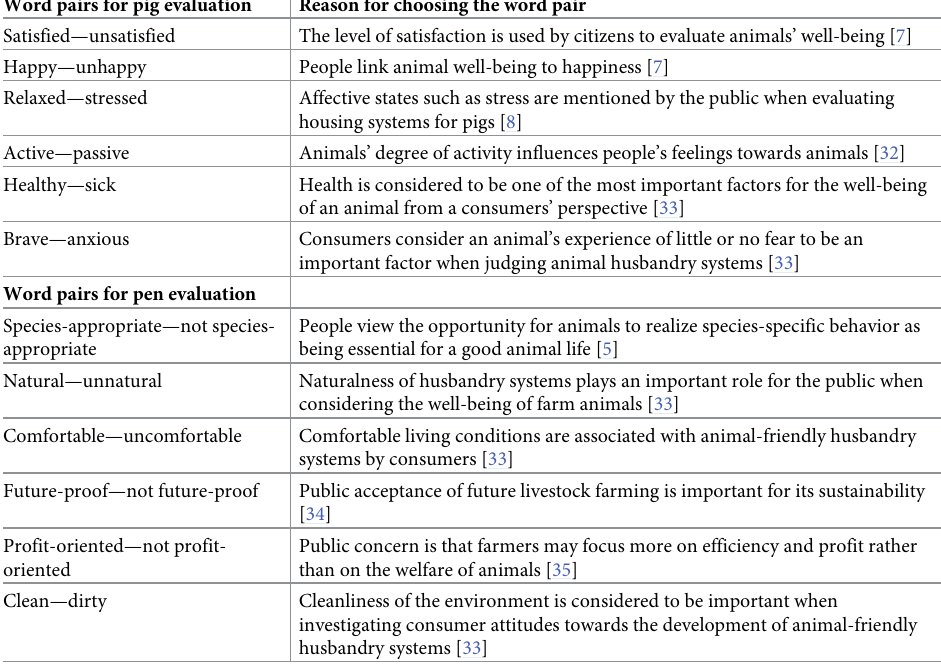
Table 1. Word pairs used for the evaluation of the pigs and pens (on a five-point semantic differential) and rea- sons for choosing the word pairs (derived from literature). Word pairs for pig